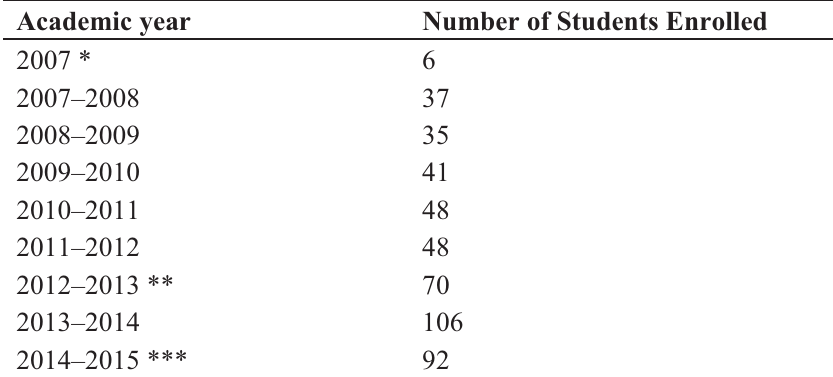
Table 6. Student enrollment. Student enrollment in the shelter elective at Mississippi State University College of Veterinary Medicine has increased consistently since the inception of the program in